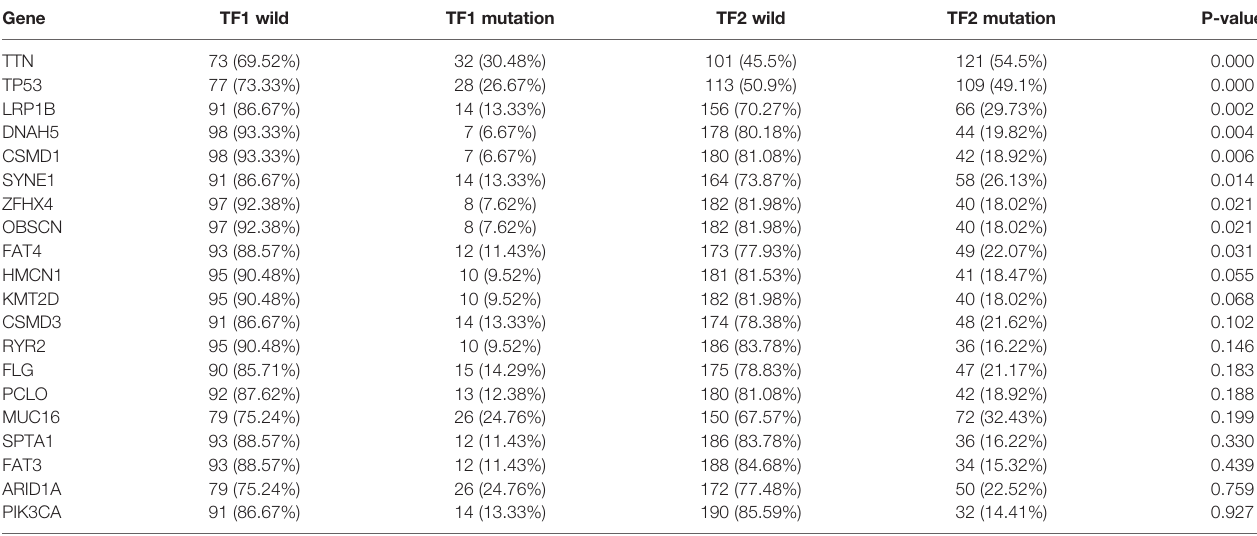
TABLE 6 | Differential mutation analysis of the top 20